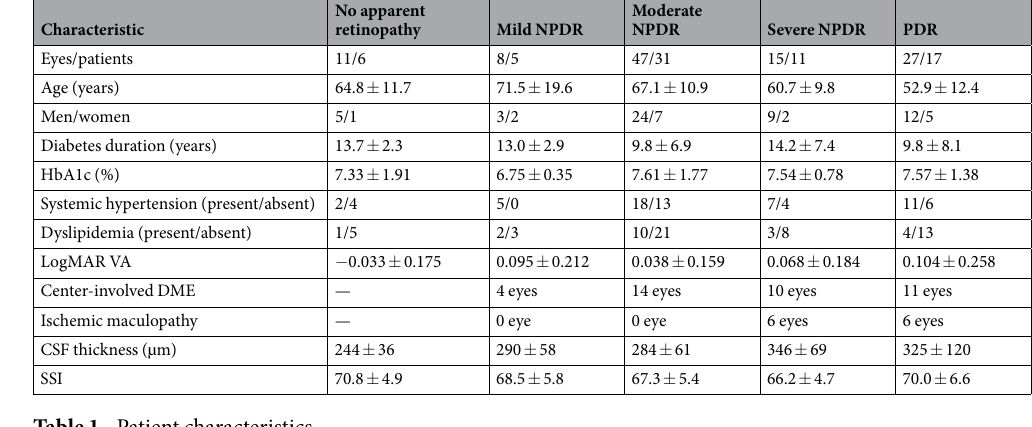
Table 1. Patient